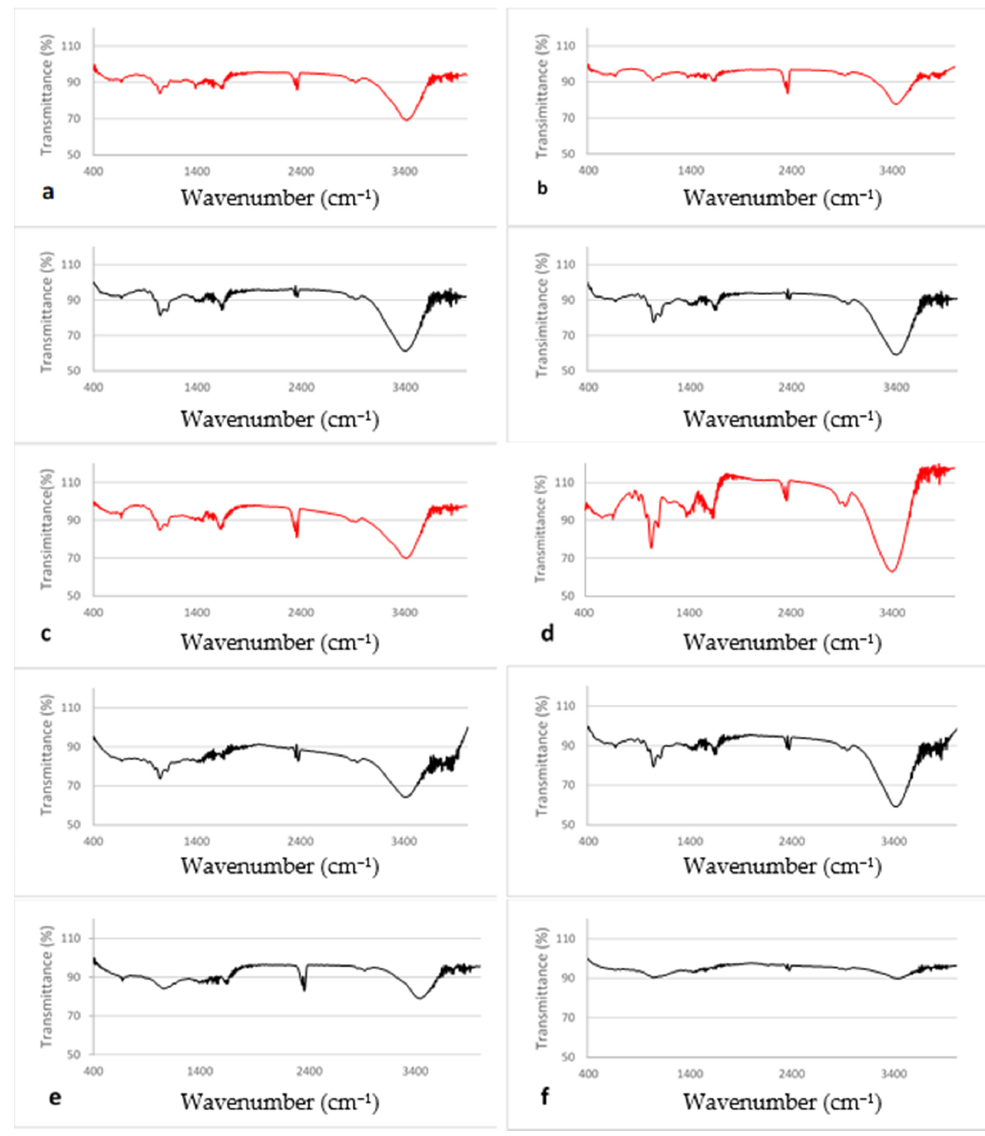
Figure 4. FTIR spectra of ( a – d ) extract AgNPs (-) and extract absorbed on active carbon (-) for ( a ) dittany, ( b ) sage, ( c ) sea buckthorn, ( d ) calendula, ( e ) NaBH 4 AgNPs, and ( f ) active